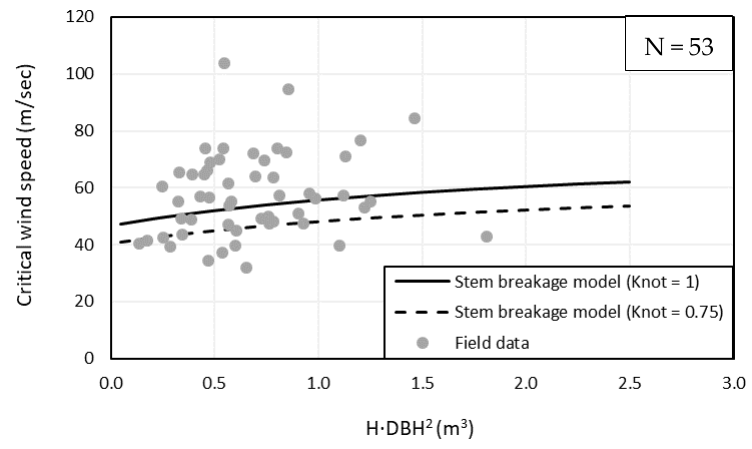
Figure 7. Relationship between critical wind speed and stem broken tree volume.